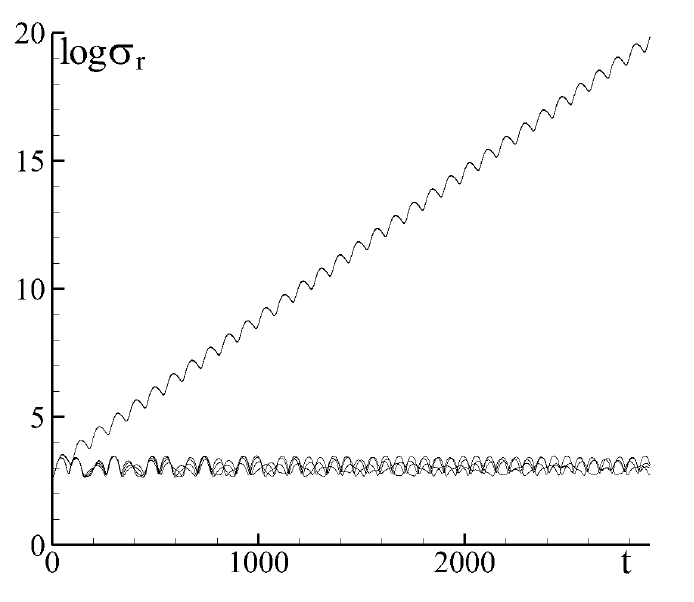
Figure 22. Standard deviations (logarithmic scale) for four combinations of the vortices’ strengths of a circular patch consisting of 10 4 markers evenly distributed over the vortices: the curves with a linear increasing trend—parametric instability manifestation; no linear trend—no parametric